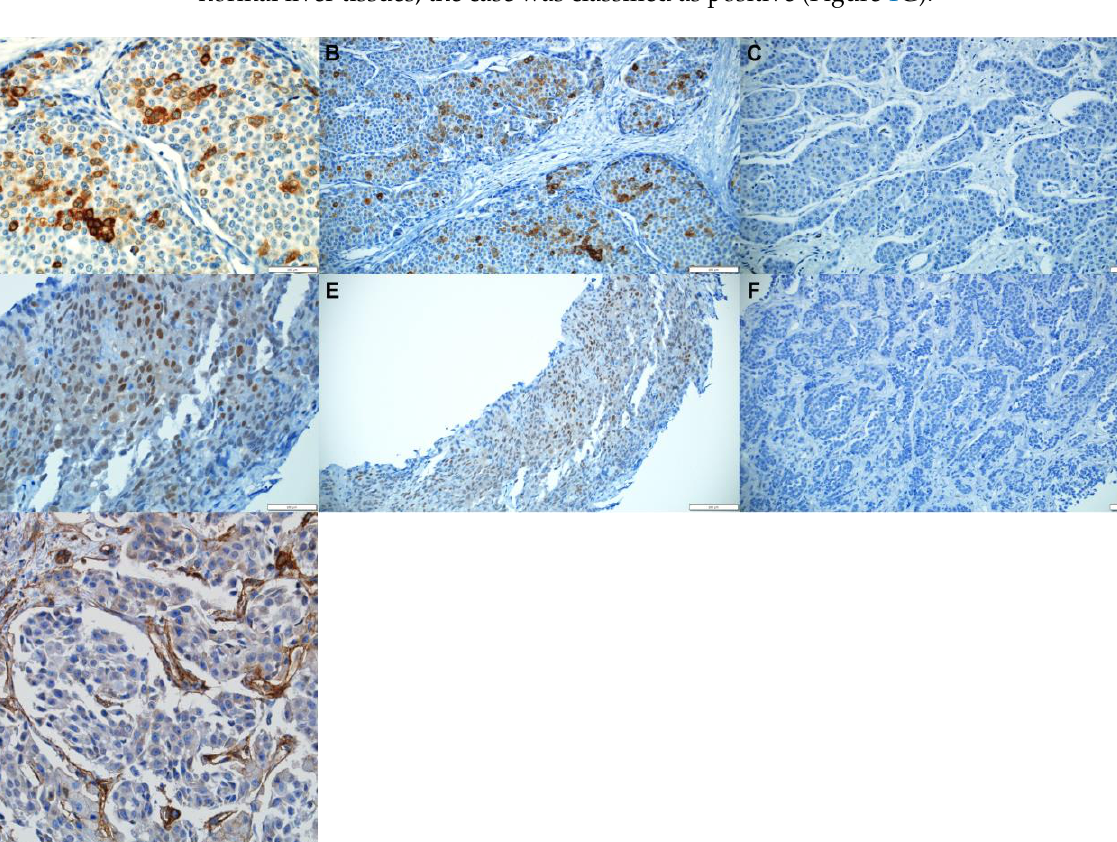
Figure 1. Immunohistochemical staining for L1CAM, YAP/TAZ and β1 -integrin in metastatic breast cancer in liver. L1CAM positive ( A , B ), L1CAM negative ( C ), YAP/TAZ positive ( D , E ), YAP/TAZ negative ( F ), and β1 -integrin positive ( G ) (( A , D , G ) ×400; ( B , C , E , F ) ×200).